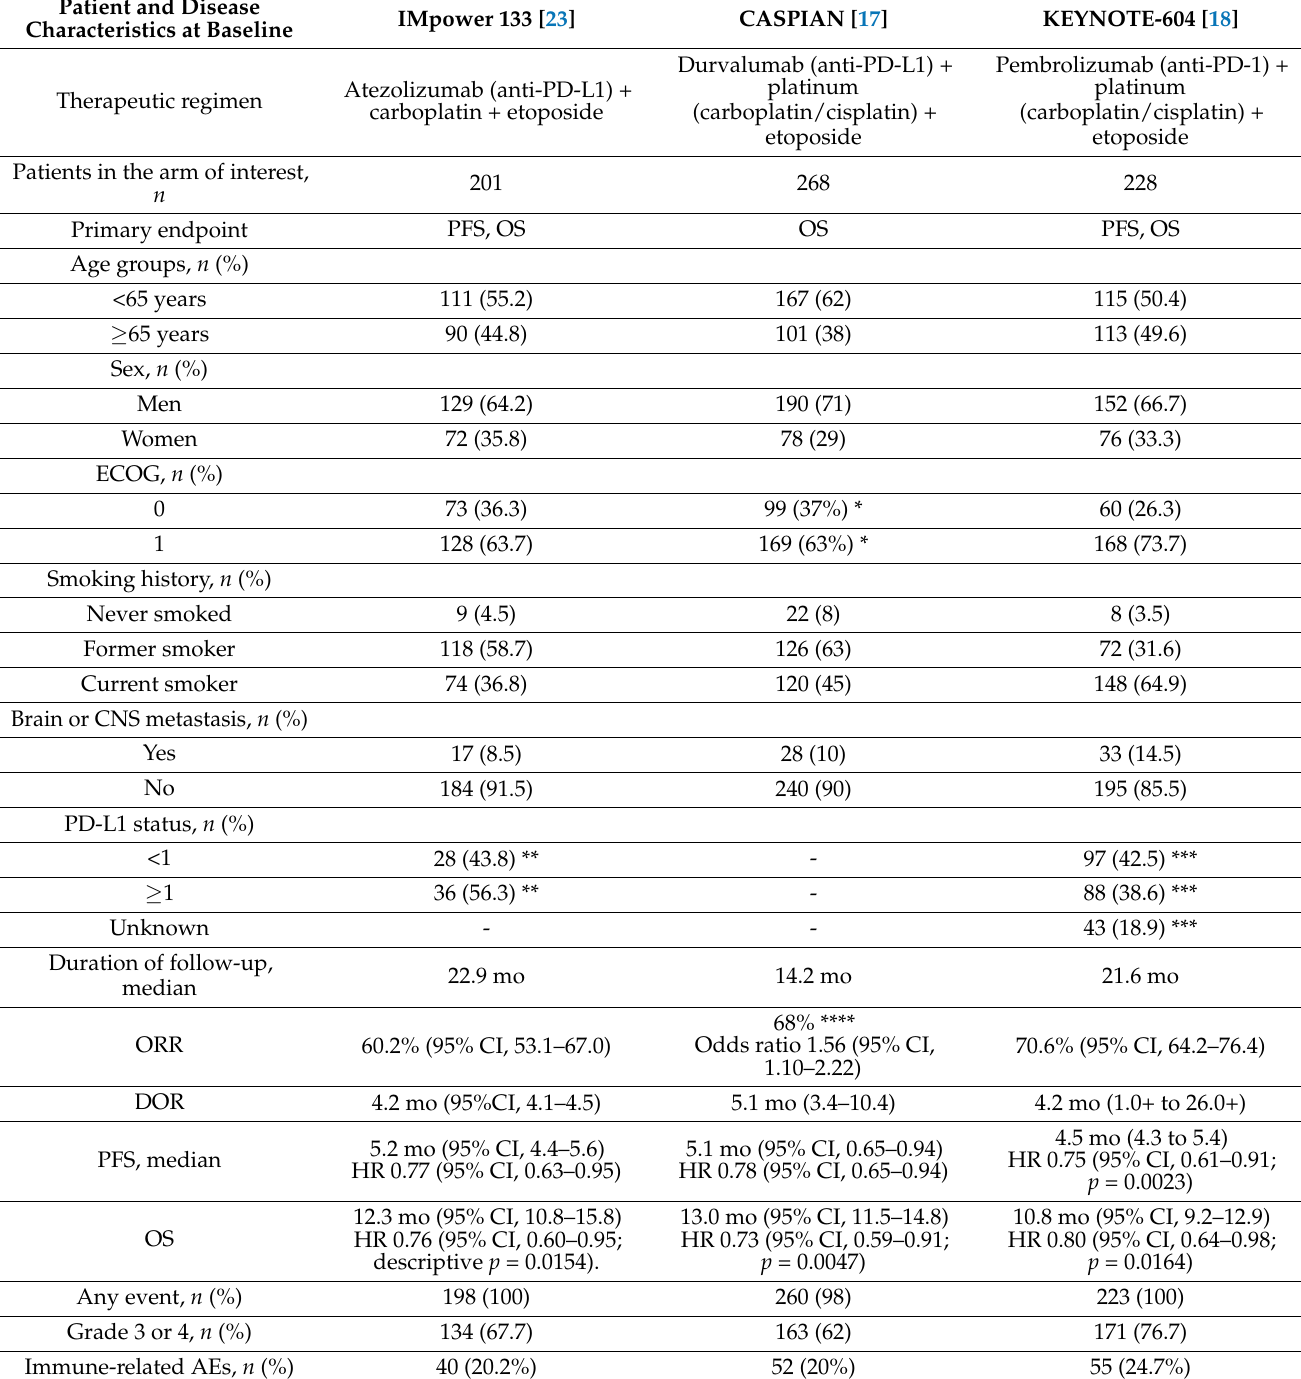
Table 3. Comparison between IMpower 133, CASPIAN, and KEYNOTE-604